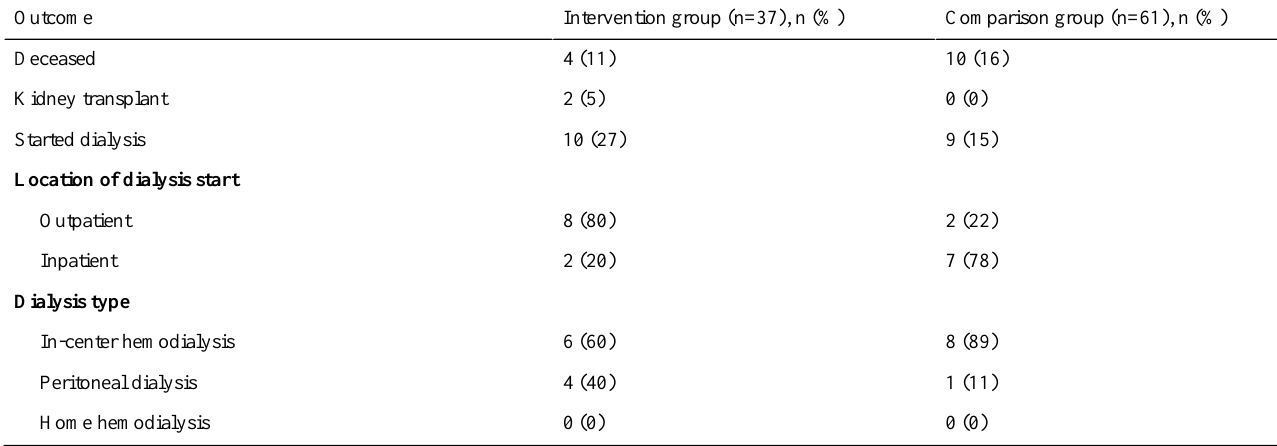
Table 4. Outcomes using all follow-up data.